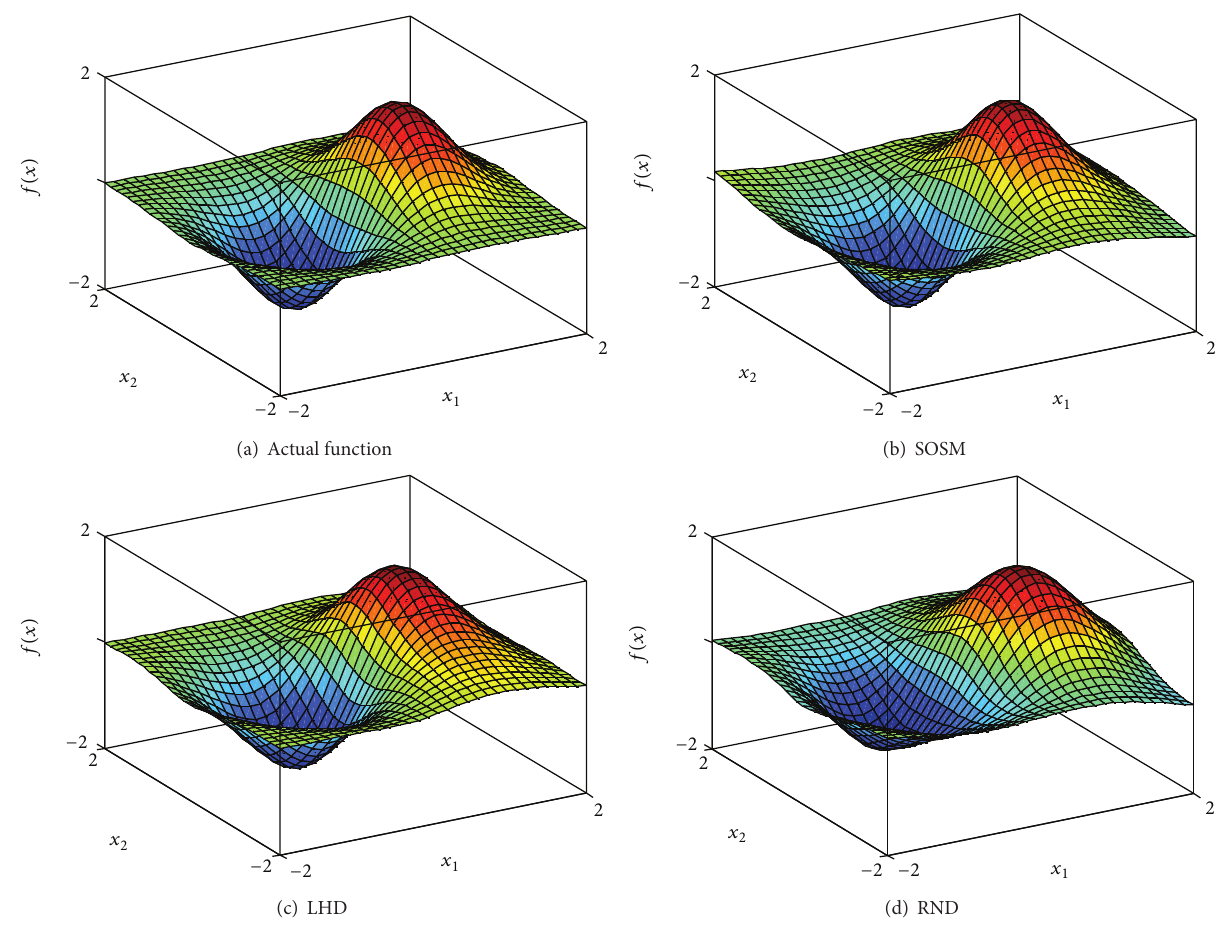
Figure 12: Function 2: actual and metamodel